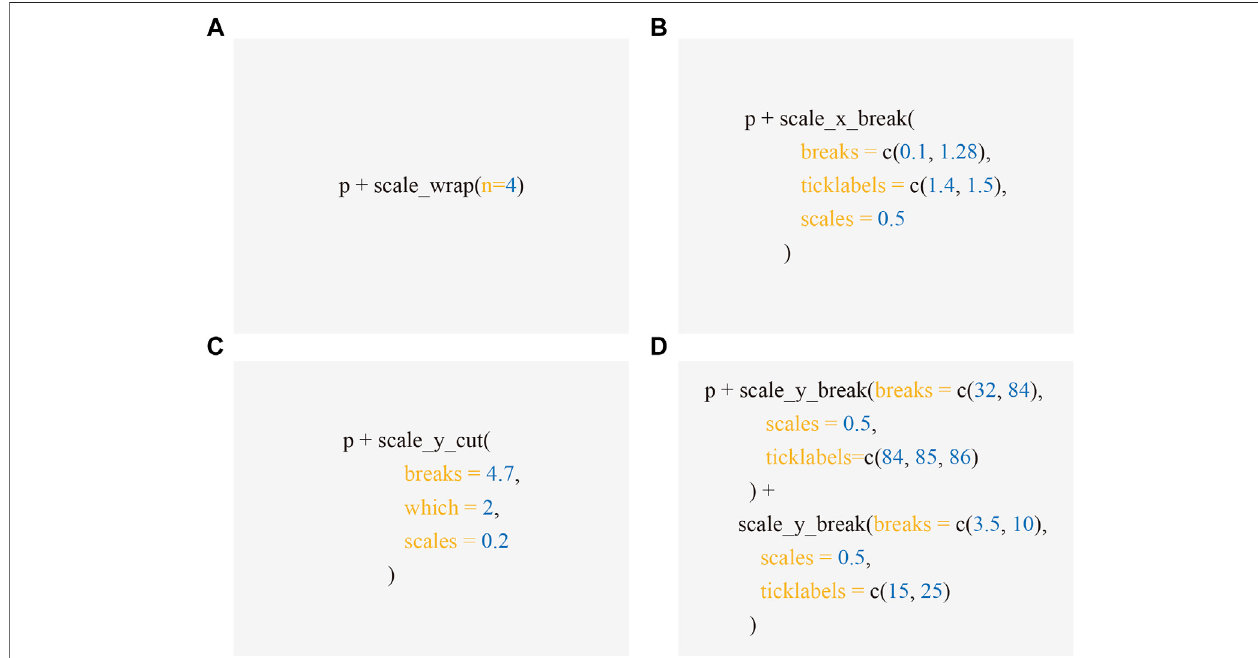
FIGURE 5 | Code excerpts to produce Figures 1 - 4 . Applying scale functions implemented in ggbreak allows creating axis break to produced Figure 1B (A) , 2B (B) , 3B (C) , and 4C (D) respectively from the subplot A, which is represented by the p object - a graphic object produced by ggplot2.